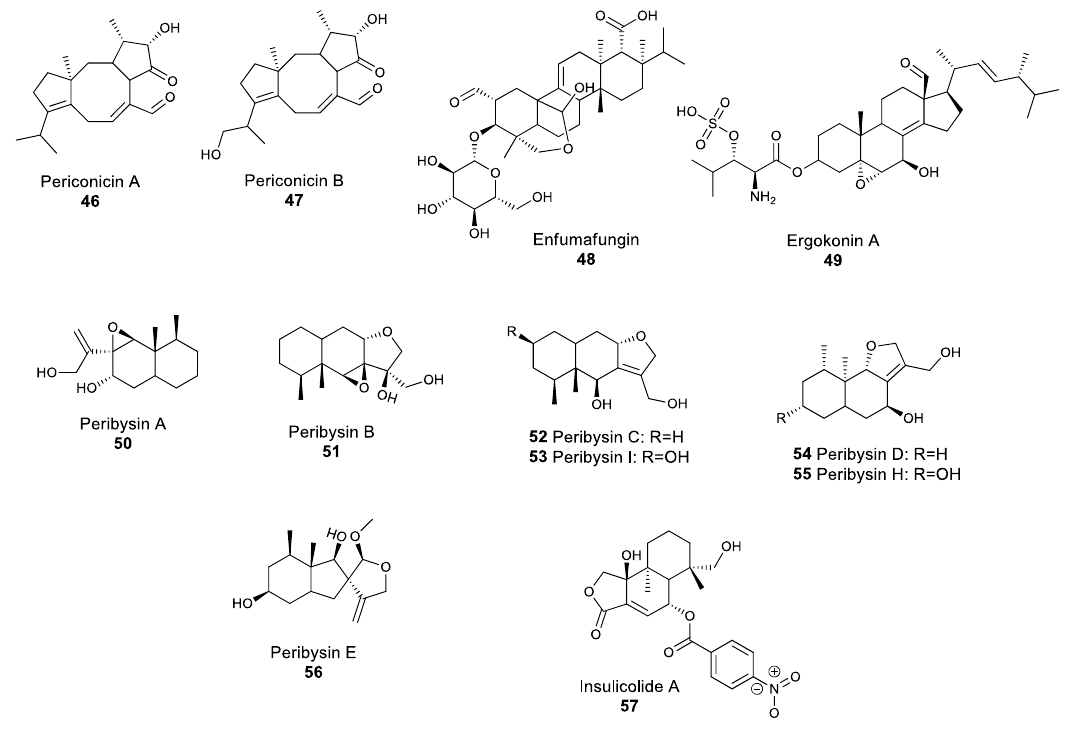
Figure 5. Structures of selected fungal terpenoids.